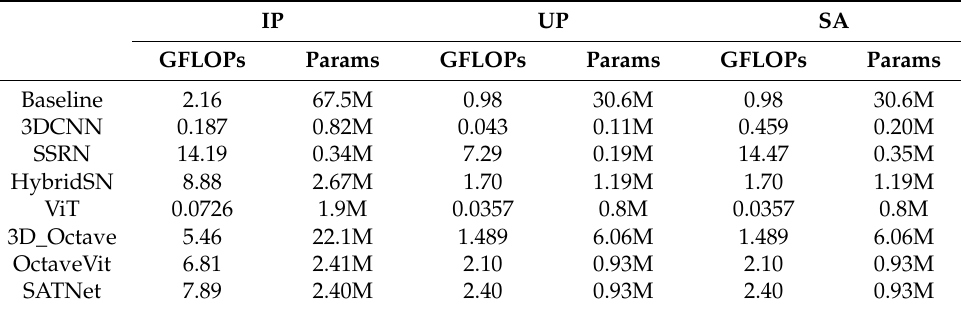
Table 9. Complexity and number of parameters of different algorithms. IP UP SA